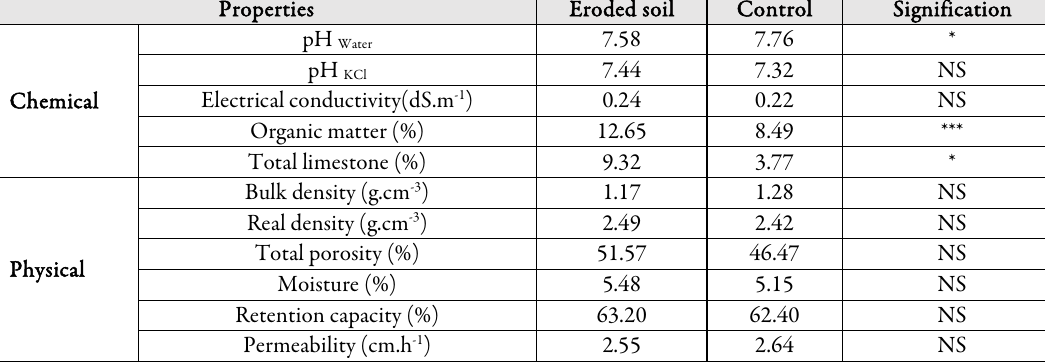
Table 1. Physico-chemical properties of control and eroded